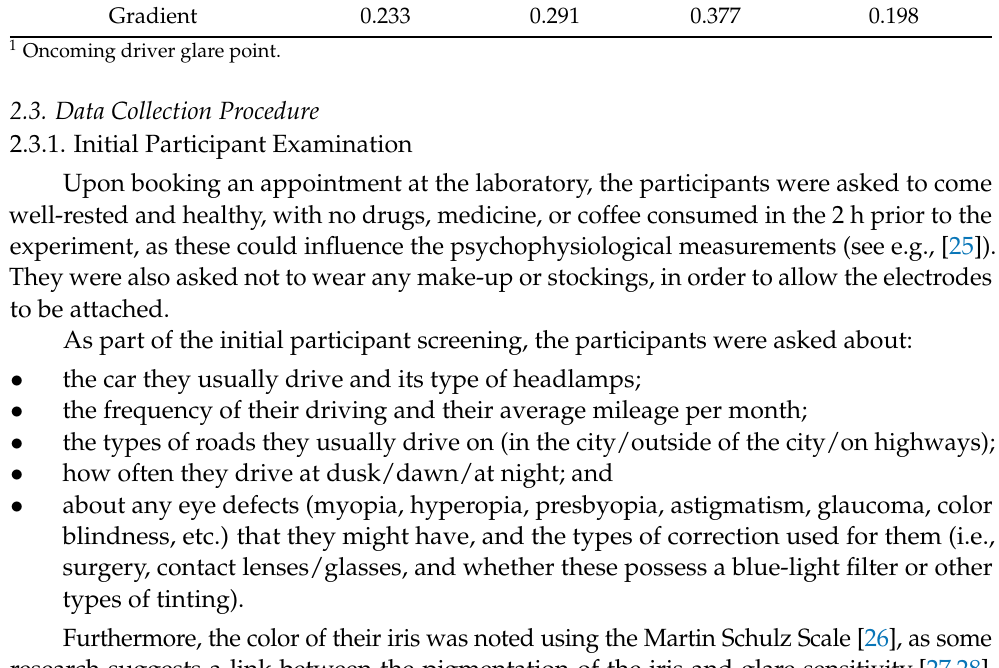
Halogen Bulb Series LED Bluish LED Yellowish Reflector Module Module